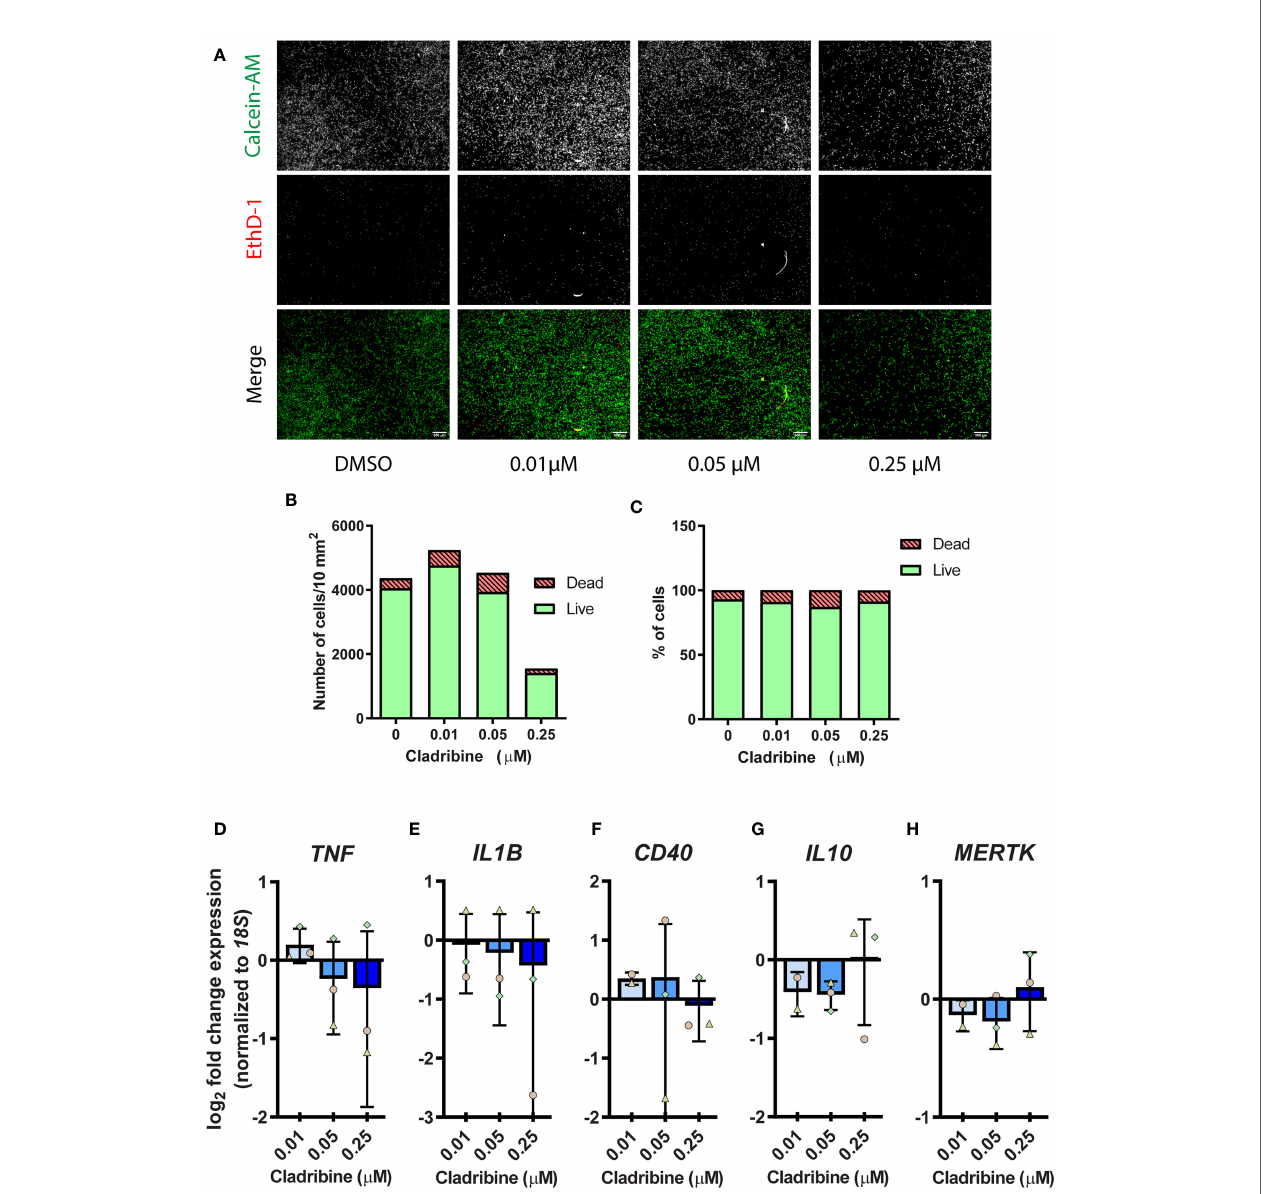
FIGURE 5 | Cell viability and gene expression of activation markers in primary human microglia treated with cladribine. Microglia isolated from temporal lobe surgical resections were treated with cladribine in vitro for 6 days. (A) Fluorescence microscopy images of human adult microglia stained with calcein-AM (green, live cells) and ethidium homodimer-1 (EthD-1) (red, dead cells) at day 6 post cladribine treatment in vitro . (B, C) Cell viability of cladribine-treated microglia as assessed by fl uorescence microscopy from panel (A) , cells positive for calcein-AM are counted as live and positive for EthD-1 are counted as dead. (B, C) Data depicted as value, n=1. (D – H) RT- qPCR gene expression analysis of (D – F) pro-in fl ammatory and (G, H) anti-in fl ammatory activation markers in microglia at 6 days post cladribine treatment. (D – H) Data depicted as mean (+ min/max) and symbols indicate matched experiments from the same brain donor. The fold change expression was calculated for the respective control of each donor. n=3 (except for 0.01 m M for genes IL10 , CD40 and MERTK , which n=2). Statistical analysis: one-way